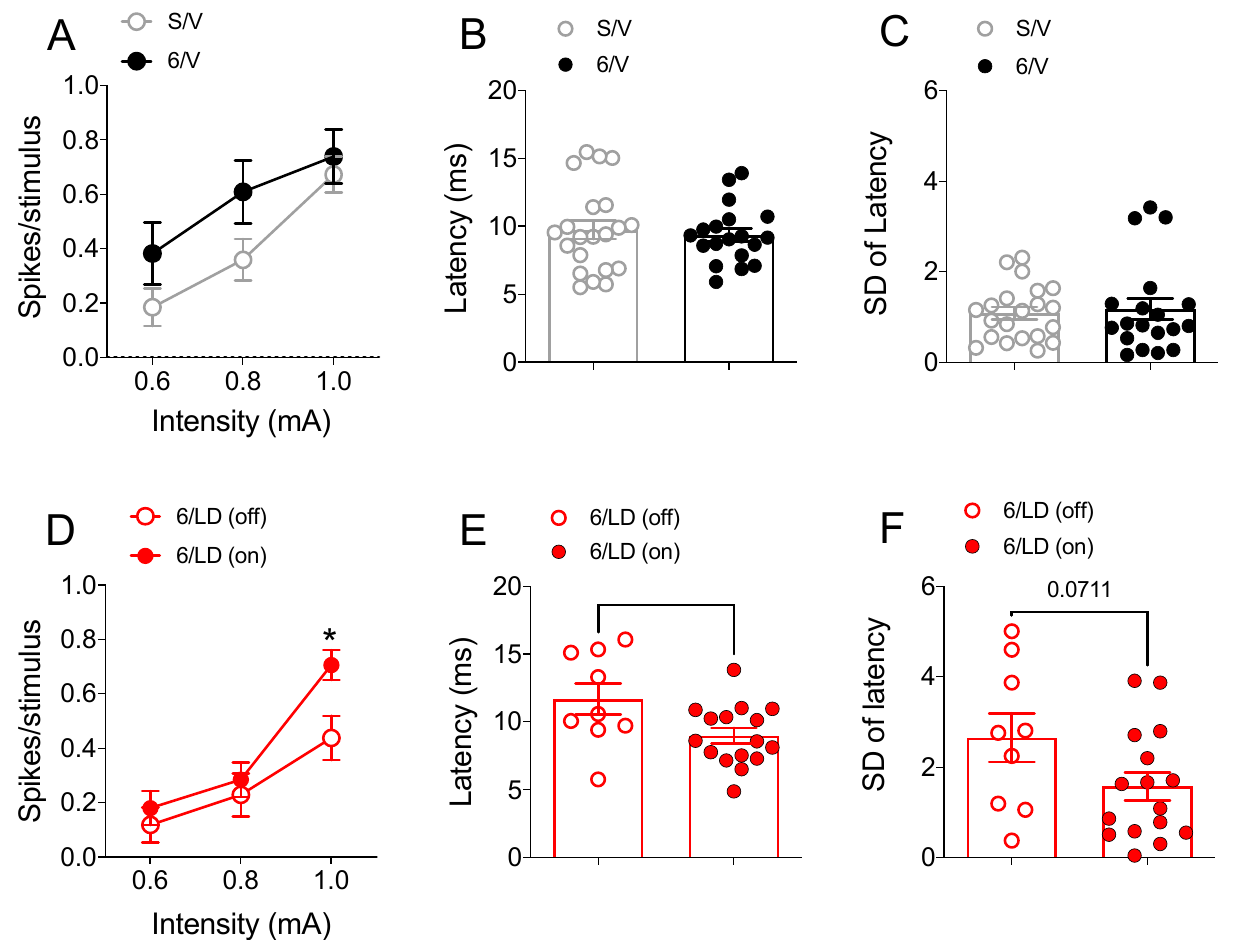
Figure 3. Corticostriatal signaling is altered in LID. ( A to C ) Current input/spike output relationship, latency to the first spike, and standard deviation of latency to the first spike observed in MSNs recorded in sham-operated and 6-OHDA-lesioned rats chronically treated with vehicle. ( A ) There was an interaction between the lesion and current intensity in the total number of spikes evoked per cortical stimulus between 6-OHDA-lesioned and sham-operated animals ( p < 0.05, two-way RM-ANOVA) but no differences in post-hoc analysis ( p > 0.05, Holm-Sidak). ( B ) Measures conducted at 1 mA cortical stimulation revealed no differences in the latency to the first spike ( p > 0.05, t -test) or in the ( C ) standard deviation of the latency to the first spike ( p > 0.05, t -test) between sham-operated and 6-OHDA-lesioned animals. ( D to F ) Current input/spike output relationship, latency to the first spike, and standard deviation of latency to the first spike observed in MSNs recorded in 6-OHDA-lesioned dyskinetic rats before (off) and after (on) L-DOPA administration. ( D ) Analysis of the total number of spikes evoked per cortical stimulus revealed that L-DOPA treatment facilitated cortically evoked responses (* p < 0.05 vs. 6/LD (off) at 1 mA, two-way RM-ANOVA and Holm-Sidak post-hoc test). ( E ) L-DOPA shortened the latency to the first spike (* p < 0.05 vs. 6/LD (off), t -test) and ( F ) reduced the standard deviation of latency to the first spike ( p = 0.071 vs. 6/LD (off), t -test). Data are presented as the mean ± SEM. Results are derived from n = 10/21 animals/cells in the S/V group, n = 6/19 animals/cells in the 6/V group, and 12/9–16 animals/cells in the 6/ LD group.